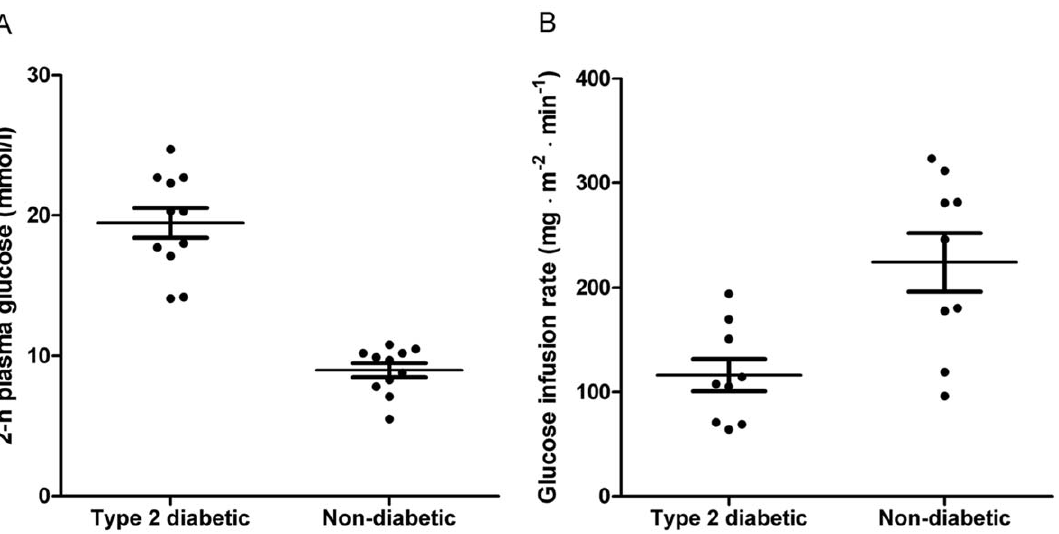
Figure 1. Discordance for oral glucose tolerance and insulin sensitivity in monozygotic twins. A Plasma glucose 120 min after a 75-g oral glucose load in type 2 diabetic and non-diabetic twins ( n =12 pairs, P , 0.001). B Glucose infusion rate during a euglycemic-hyperinsulinemic clamp in